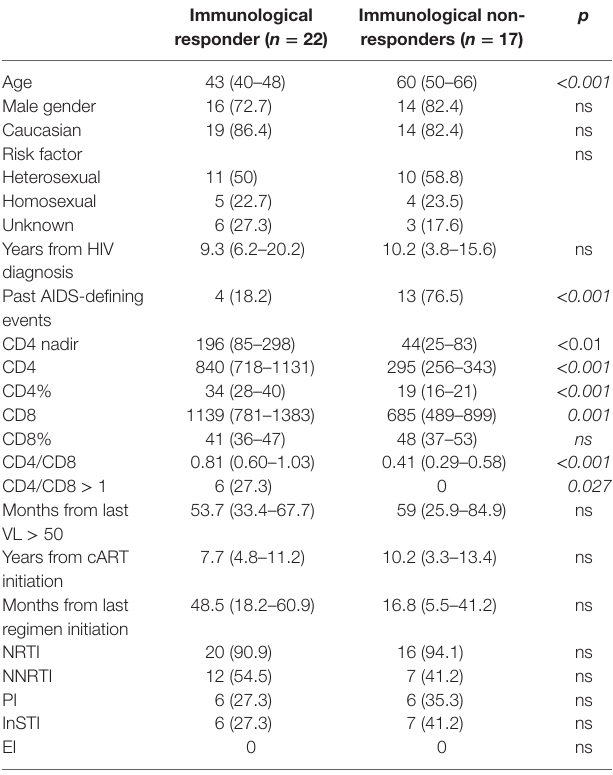
TaBle 1 | Clinical and demographic characteristics of HIV-infected patients enrolled in the study. immunological responder ( n = 22)